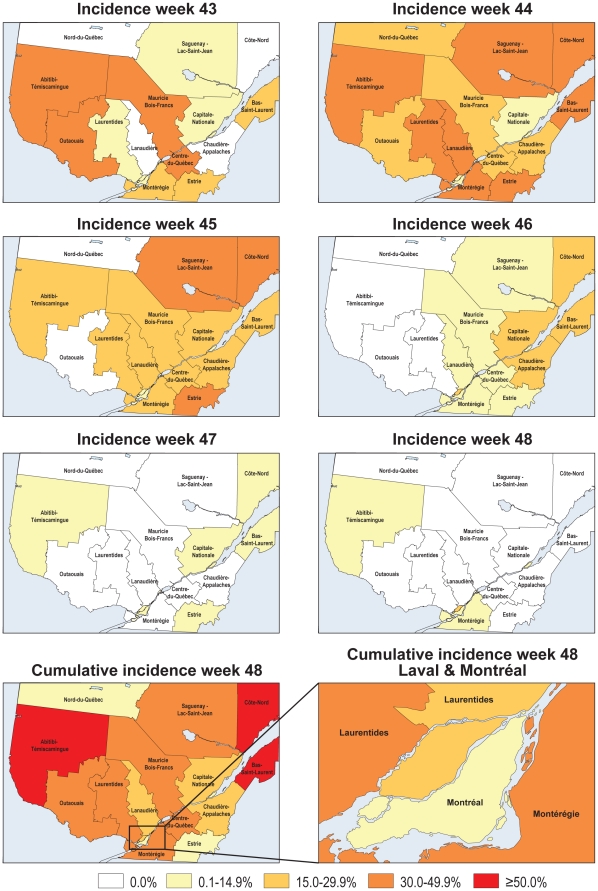
Weekly incidence of affected schools from week 43 to week 48(six upper panels); cumulative incidence of affected schools in the province at the end of the study (bottom left panel); cumulative incidence of affected schools in the regions of Montreal and Laval at the end of the study (bottom right panel).